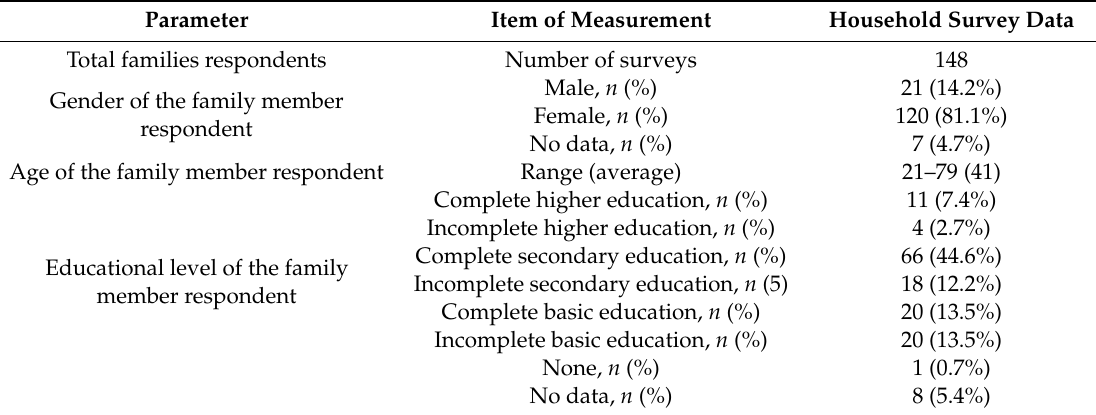
Table 3. Profile of the household